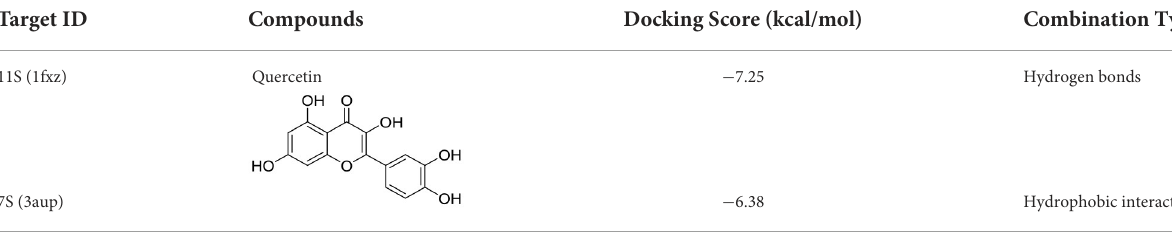
TABLE 3 The selected compounds of docking results.